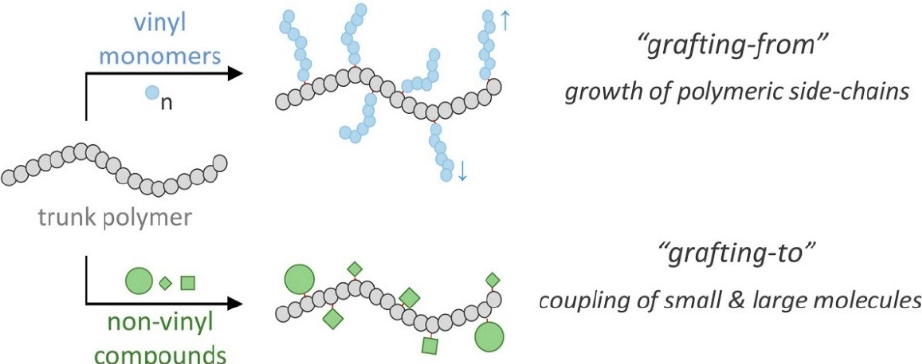
Figure 1. Comparison of the two most common grafting approaches: grafting from and grafting to.